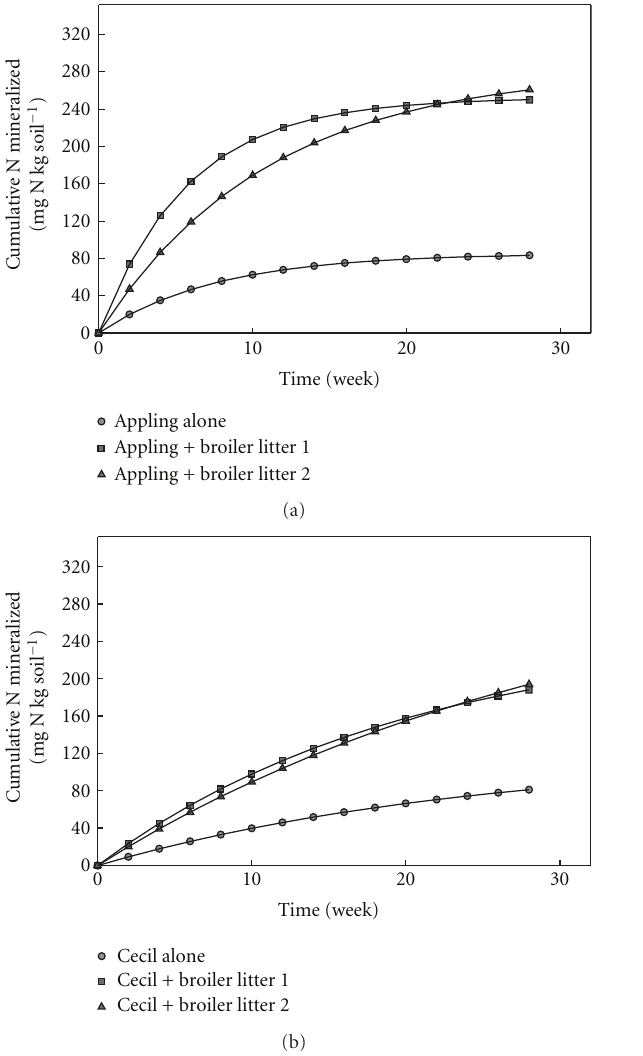
Figure 1: Cumulative organic nitrogen mineralized from Appling (a) or Cecil (b) soils amended with broiler litter 1 or 2 and incubated for 28 weeks under aerobic conditions.